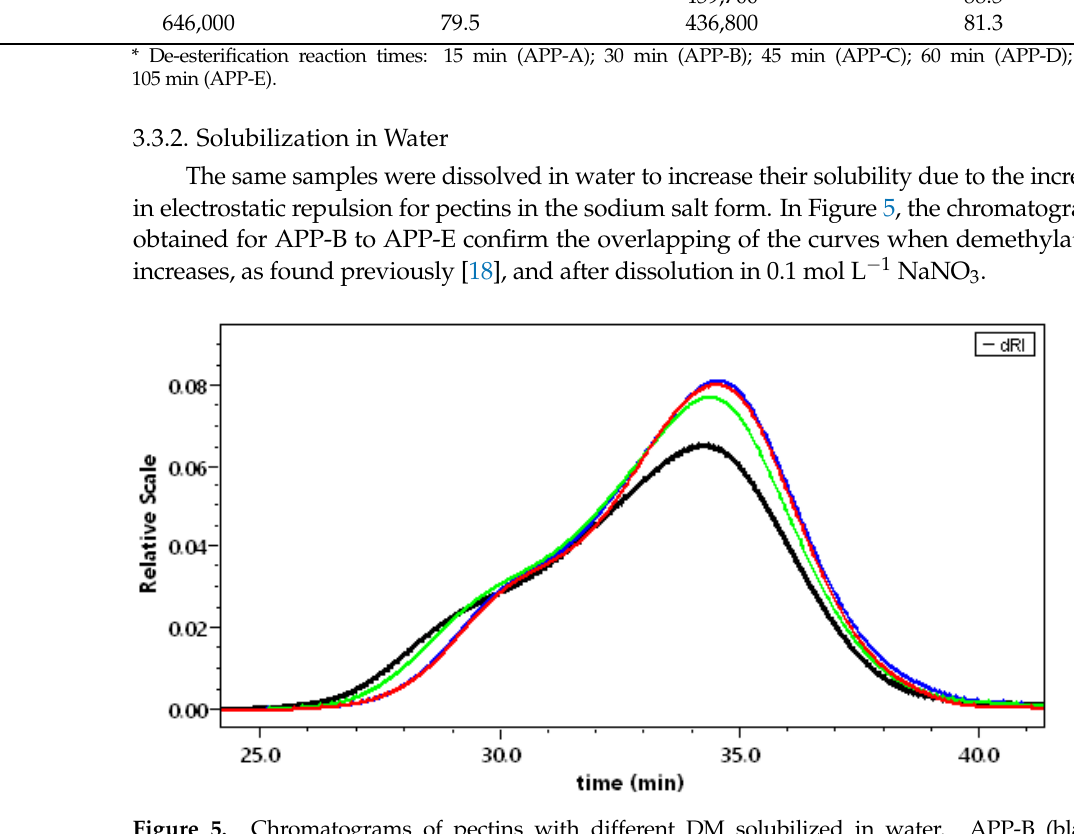
Figure 4. Chromatograms of the different pectins dissolved in 0.1 mol L −1 NaNO 3 . APP (red); APP- A (green); APP-B (brown); APP-C (pink); and APP-E (blue).